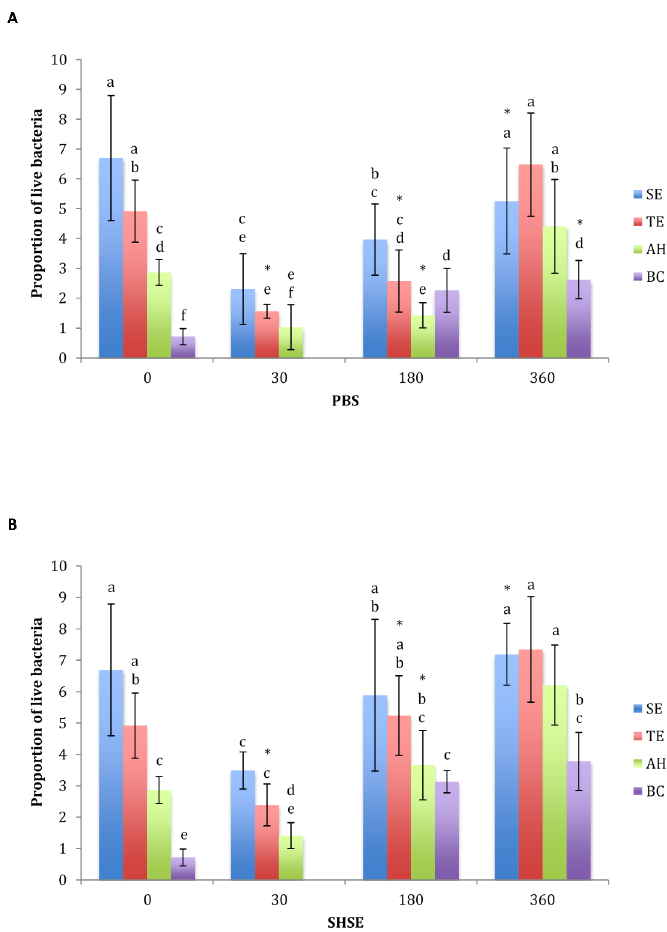
Figure 3. Proportion of live bacteria in interfacial biofilms for the test groups (SE, self-etch adhe- sive; TE, total-etch adhesive; AH, epoxy-resin sealer; BC, bioceramic sealer) before and after aging for 30, 180, or 360 days in ( A ) PBS or ( B ) SHSE. Data are shown as mean ± SD. * Indicates significant difference between PBS and SHSE of the same material at same time point.